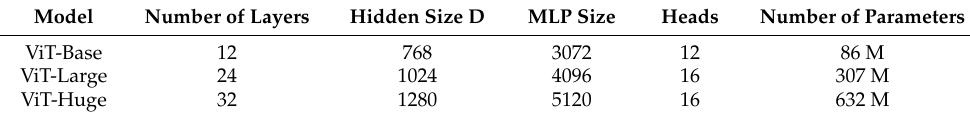
Table 1. Parameter statistics for the Base, Large and Huge variants of Vision